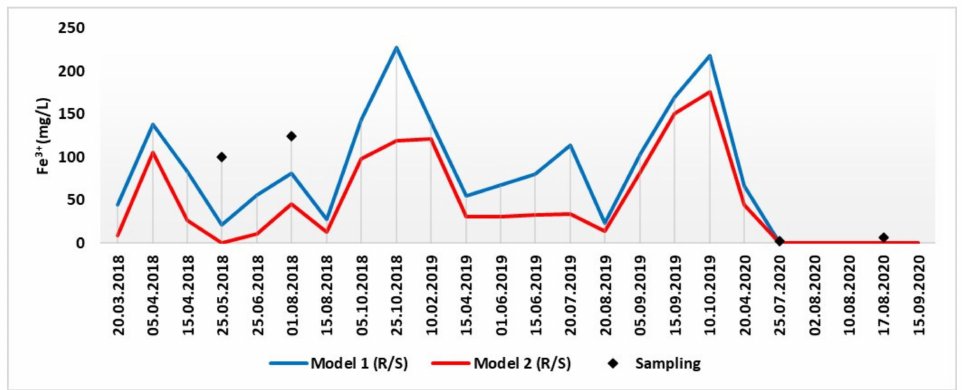
Figure 18. Development of Fe 3+ concentration over time in the Grüner